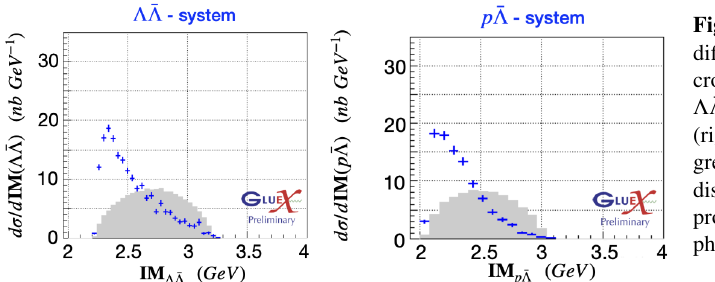
Figure 2. Preliminary di ff erential cross-sections for the Λ ¯ Λ (left) and the p ¯ Λ (right) systems. The grey areas indicate the distribution expected for production uniform in